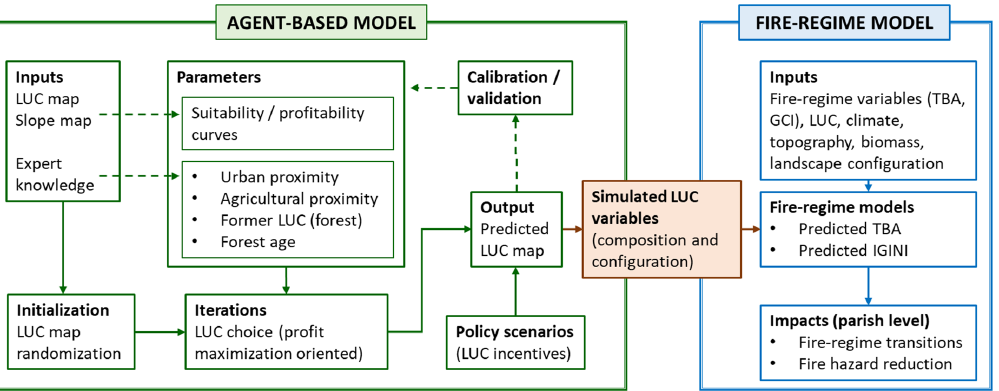
Figure 4. Overall flow of the analytical framework integrating the agent-based model with the fire regime model. regime